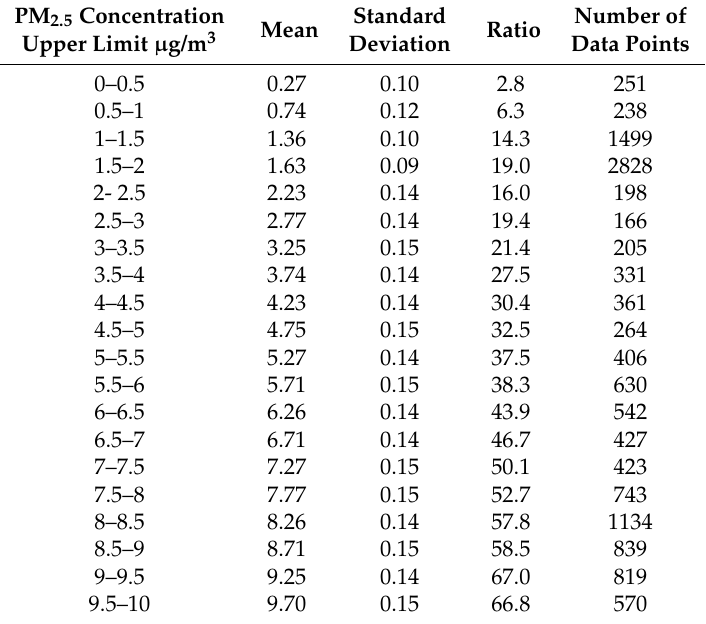
Table A5. PM 2.5 concentration range, the mean and the standard deviation of the PM 2.5 concentrations within that range, the ration of the mean and the standard deviation and the number of data points used for the calculations for Novafitness SDS018. The Lower limit of detection with Wallace et al. [65] method is defined as the PM 2.5 concentration above which the ratio is >